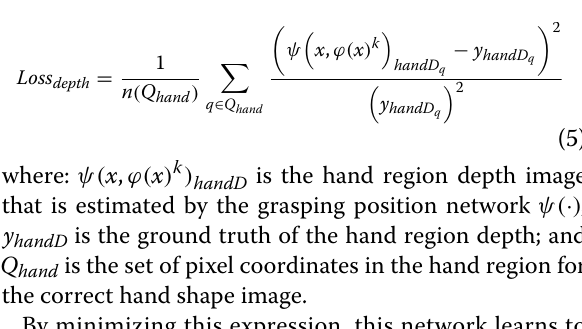
representing the hand region is given as the ground